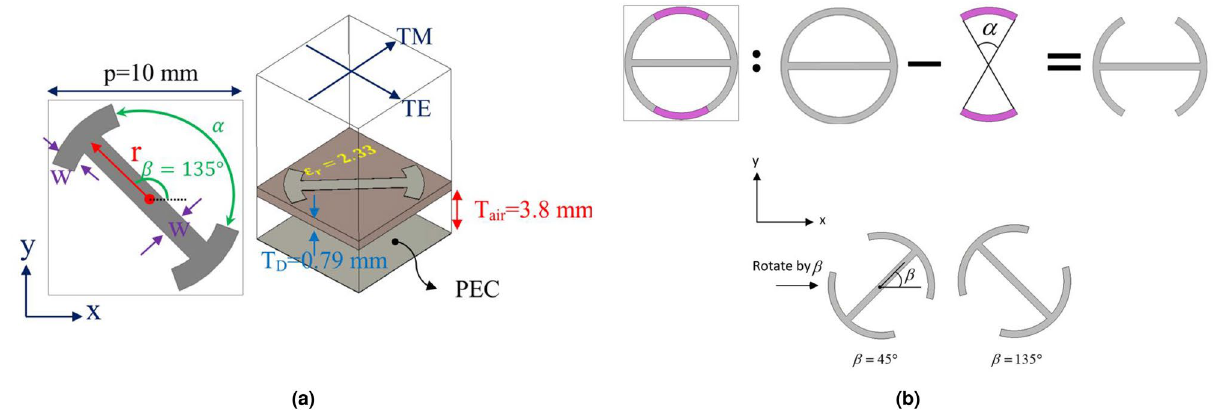
Figure 2. ( a ) Polarization rotating element and its geometrical parameters.( b ) Construction steps of the metal patch of the unit cell element.